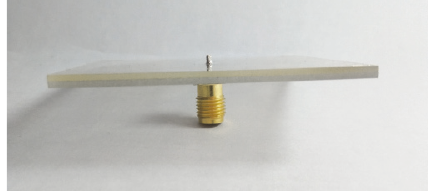
Figure 6: Side view of the fabricated proposed antenna.